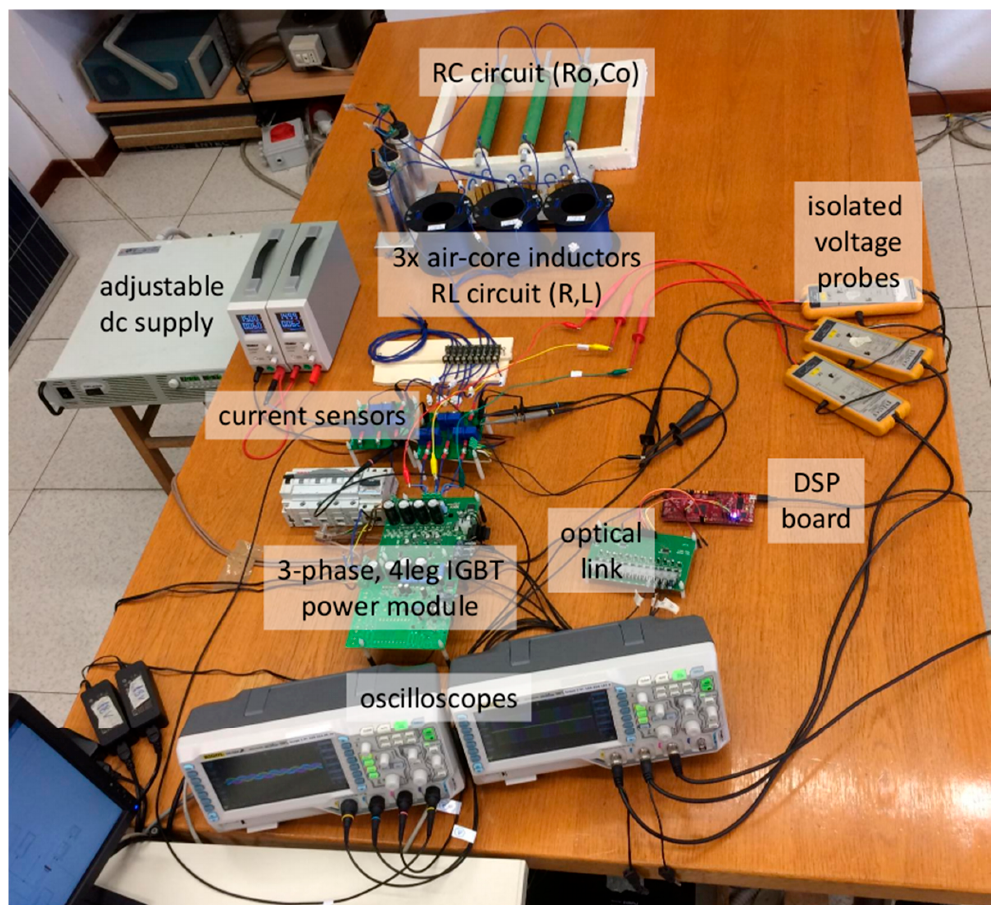
Electronics 2021 , 10 , x FOR PEER REVIEW Figure 15. View of the laboratory experimental setup (ref. to Figure 3). Figure 15. View of the laboratory experimental setup (ref. to Figure 3).